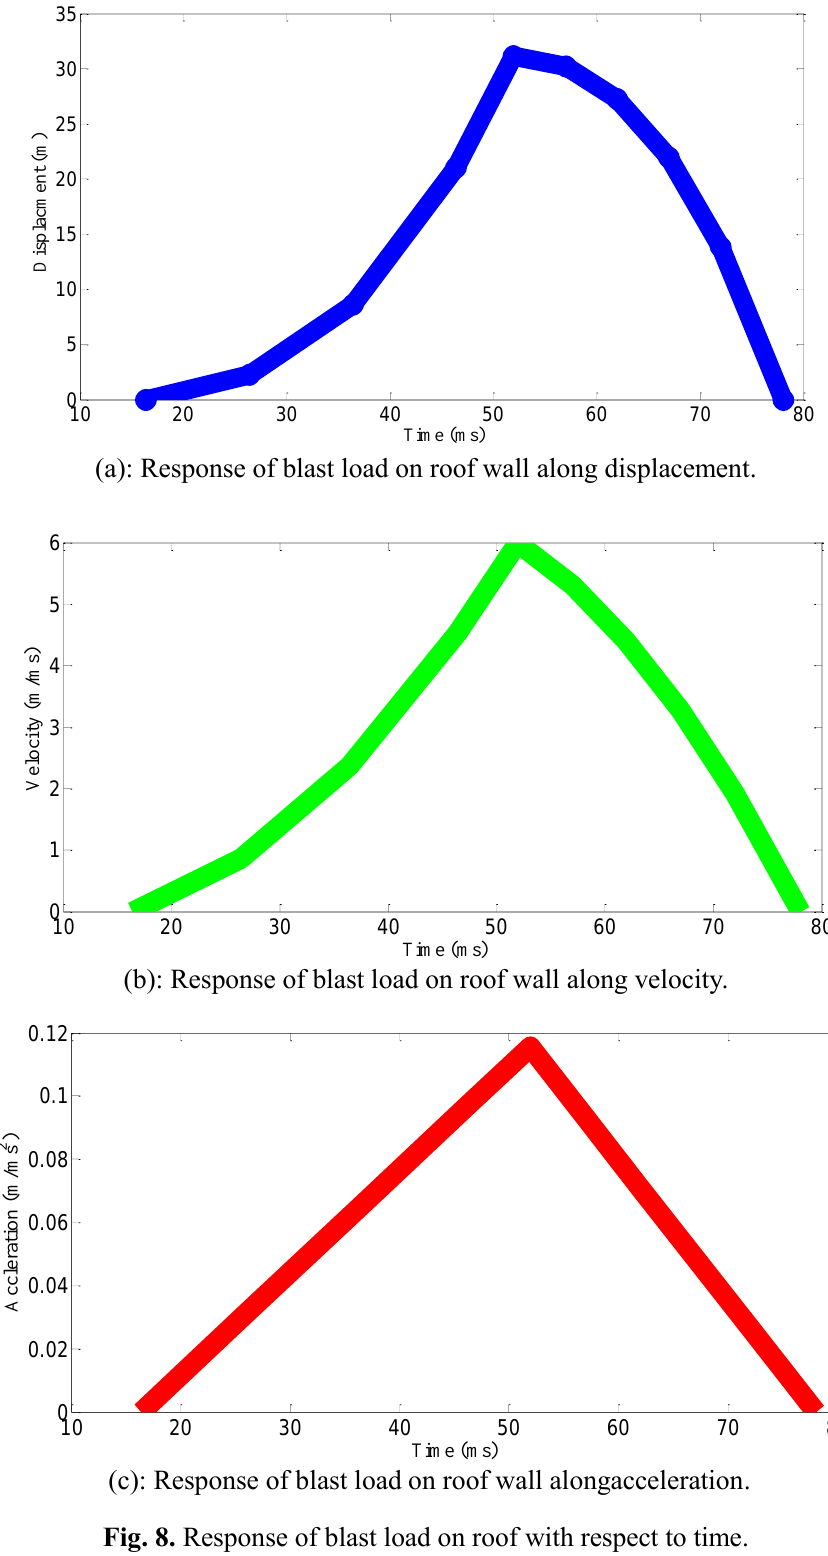
The Figure 8 represents the response of blast load acting on roof side for bare SDOF system.